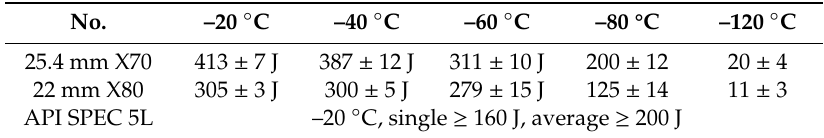
Table 4. Impact energy of X70 and